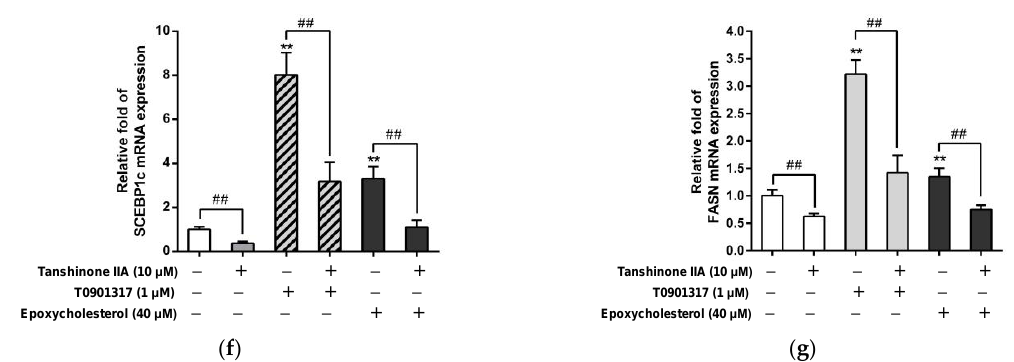
Figure 7. Effects of tanshinone IIA on LXR α expression and ligand-induced LXR α activation in HepG2 cells. HepG2 cells were treated with vehicle (0.1% DMSO) or tanshinone IIA (5 and 10 µ M) for 24 h. ( a ) The mRNA expression of LXR α was measured by RT-qPCR analysis. The data are presented as the mean ± SD of three independent experiments. ( b ) The nuclear protein expression of LXR α and HDAC2 was measured by Western blot analysis. A represent blot is shown. ( c ) Normalized intensities of LXR α versus HDAC2 is presented as the mean ± SD of three independent experiments. The chemical structure of ( d ) T0901317 and ( e ) 24(S),25-epoxycholesterol HepG2 cells were pretreated with vehicle (0.1% DMSO) or tanshinone IIA (10 µ M) for 1 h followed by treatment with agonist T0901317 (1 µ M) or 24(S),25-epoxycholesterol (40 µ M) for 24 h. The mRNA levels of ( f ) SREBP-1c and ( g ) FASN were measured by RT-qPCR analysis. ** p < 0.01 indicates a significant difference compared to compound-untreated group. ## p < 0.01 indicates significant differences compared to cells treated with the agonist alone.